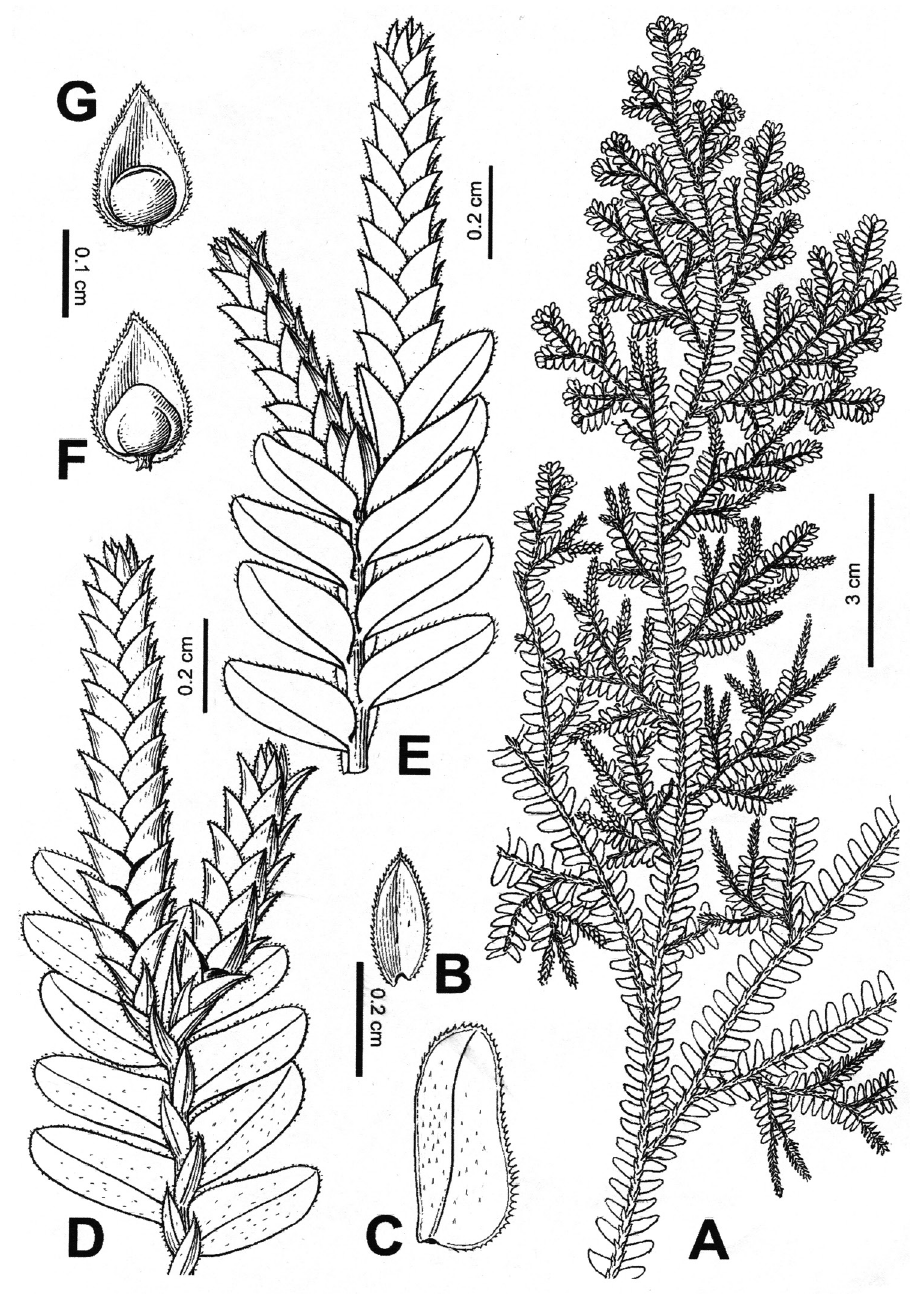
Figure 2. Selaginella guihaia X.C.Zhang A Habit B Dorsal leaf C Ventral leaf D Part of main stem showing ventral leaves, dorsal leaves, and strobili E Part of main stem showing ventral leaves, axillary leaves, and strobili F Megasporophyll G Microsporophyll (Drawn by C.Z. Ji from Beijing Youth Expedi- tion 0980 ,